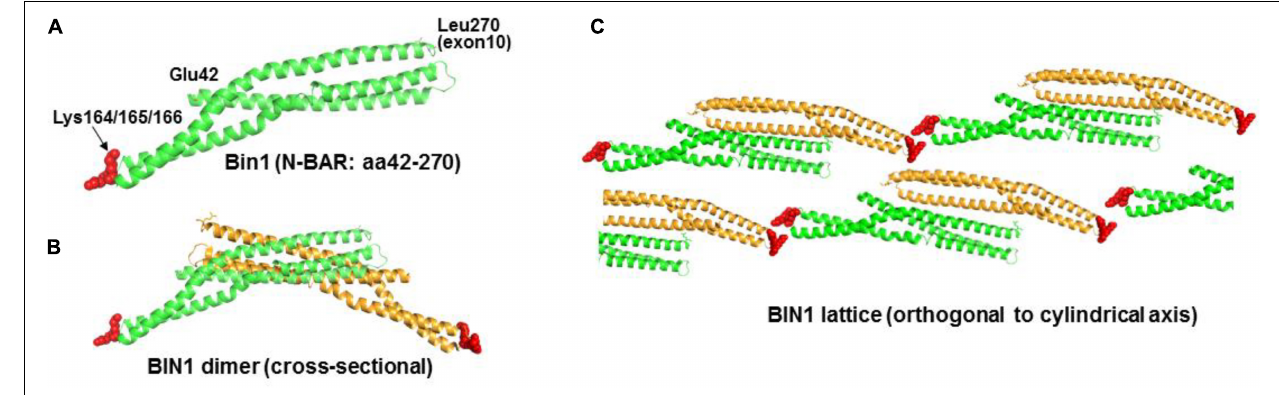
FIGURE 8 | Proposed model of BIN1 in T-tubule formation. (A) Crystal structure of N-BAR of BIN1 (PDB ID: 2FIC) consists of a coiled-coil domain. The short loop segment between helix 2 and 3 has three lysine residues from amino acid 164 to 166 (red). (B) Two BIN1 N-BARs (one in green color and the other in orange color) form a “banana”-shaped curve through their lateral interactions. (C) In T-tubule formation, BIN1 N-BAR domain oligomerizes to form a patterned lattice (modeled based on F-BAR domain) around the lipid